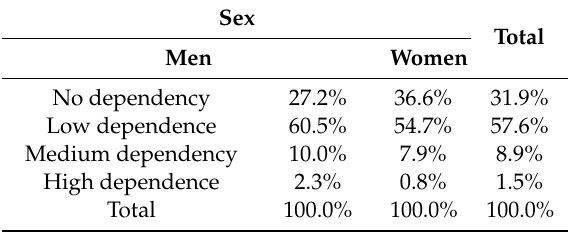
Table 1. Percent distribution of alcohol dependence level by